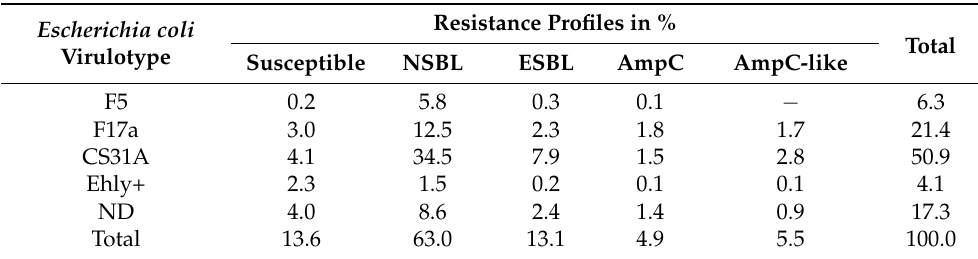
F5: fimbriae F5 expressed by Escherichia coli . F17a: fimbriae F17a expressed by Escherichia coli . CS31a: surface antigen CS31a expressed by Escherichia coli . Ehly+: Escherichia coli producing an enterohaemolysin. ND: Escherichia coli with virulence factors not determined. NSBL: narrow-spectrum β -lactamase. AmpC-like: NSBL with nonsusceptibility to cefoxitin. AmpC: cephalosporinase. ESBL: extended-spectrum β -lactamase. − : No isolates in this category were